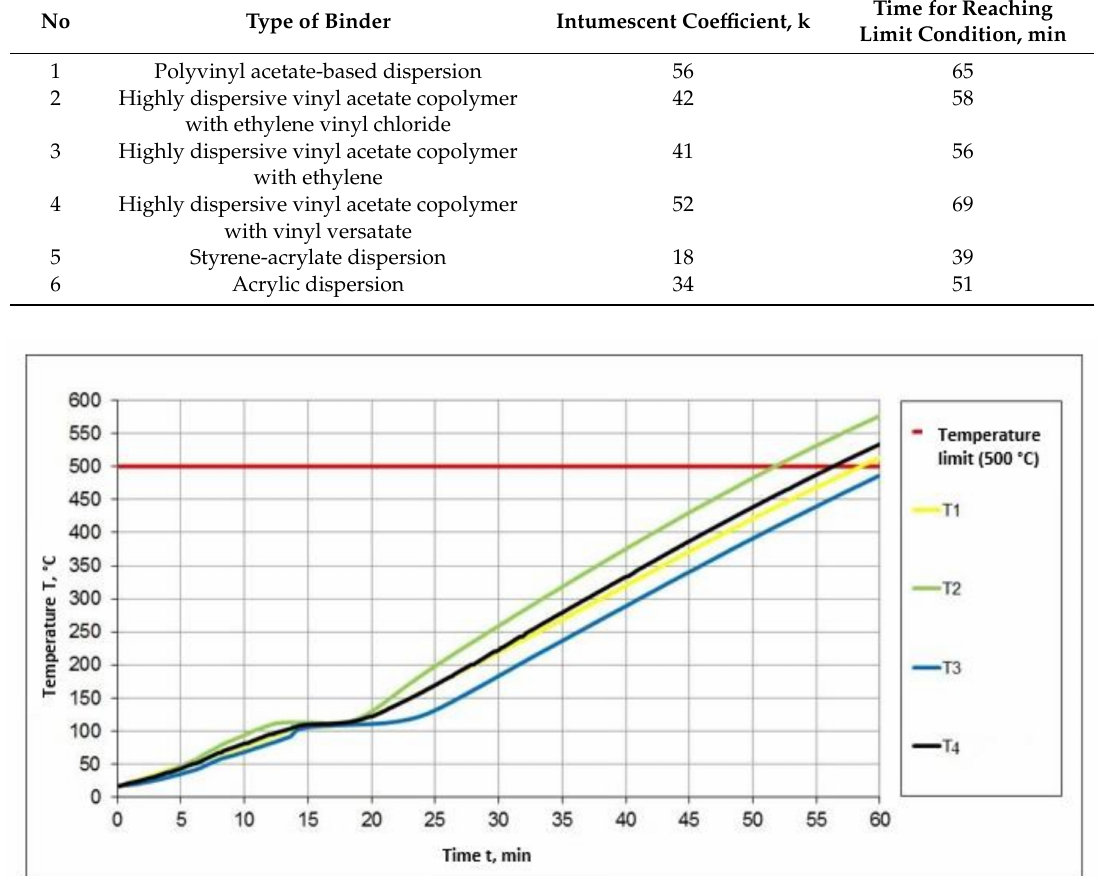
Figure2. Timelineforthetemperatureextremesofthepaintsamplesforthevariousbinders. T1—sample No. 1; T2—sample No. 2; T3—sample No. 3; T4—sample No.